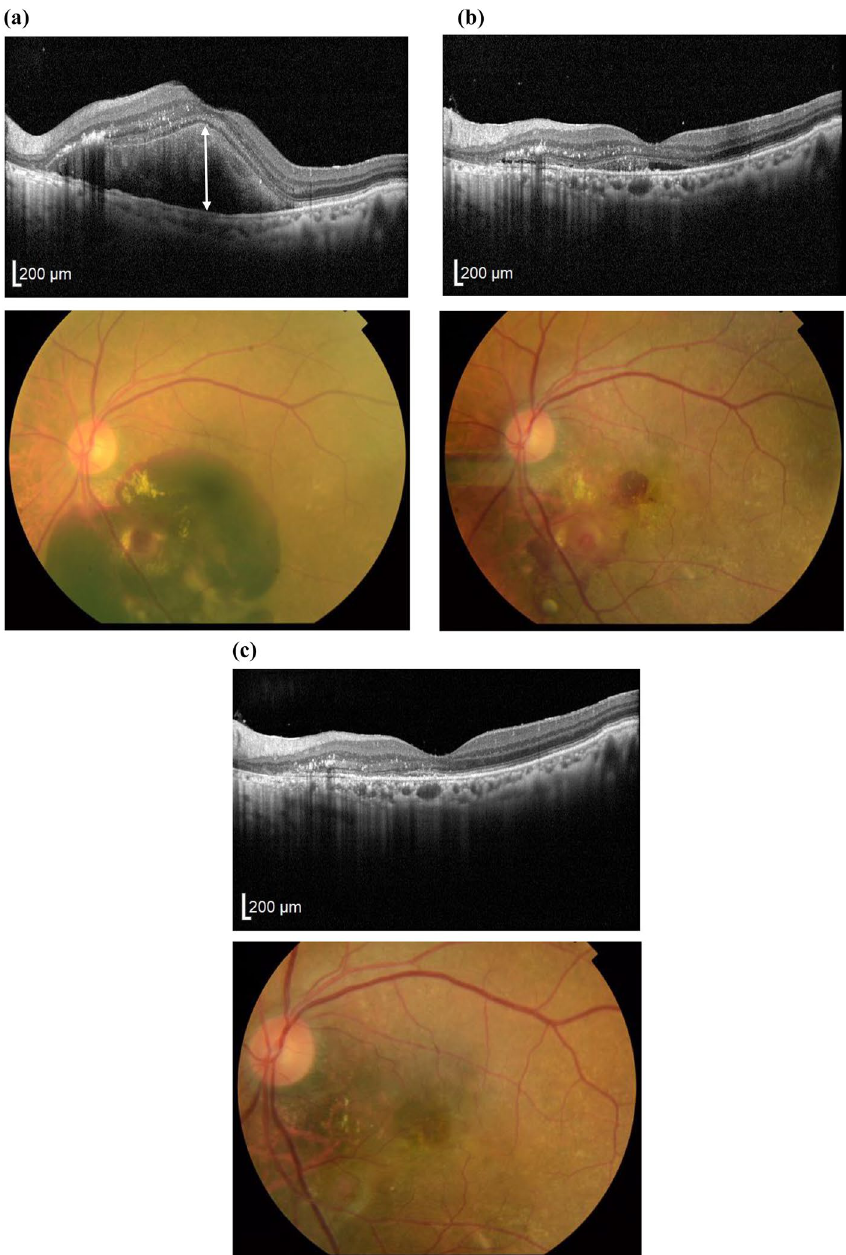
Figure 6. A case of an 83-year-old woman (patient 11). Horizontal OCT images and color fundus photographs at ( a ) baseline, ( b ) 1 month, and ( c ) 3 months post-surgery. Preoperative BCVA was 20/250, and SMH height (double headed arrow) was 604 μm. ( a ) The ellipsoid zone was absent before surgery. ( b ) At 1 month after surgery, SMH decreased to 66 μm. ( c ) At 3 months after surgery, SMH was completely absorbed and BCVA improved to 20/25. The ellipsoid zone was detectable at the